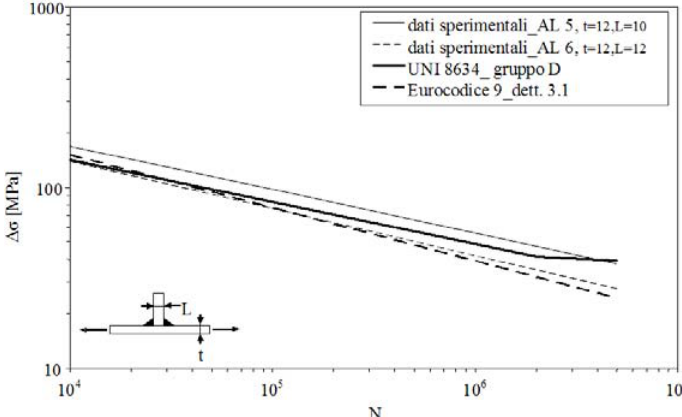
Figura 9: Confronto tra curva di resistenza a fatica per lamiera con irrigidimento trasversale (giunto a T).